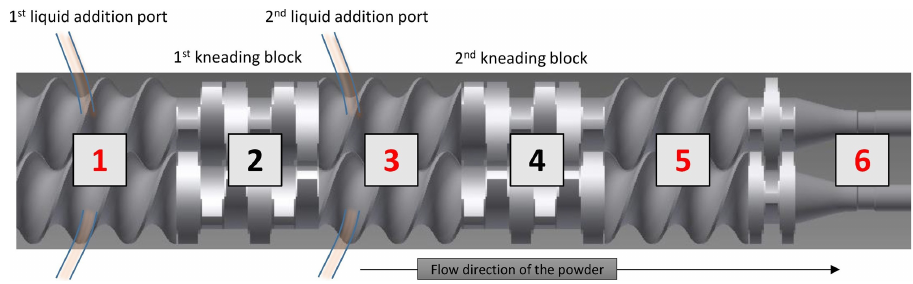
Fig. 5. Schematic diagram of the twin-screw granulation. Reproduced from Ref.